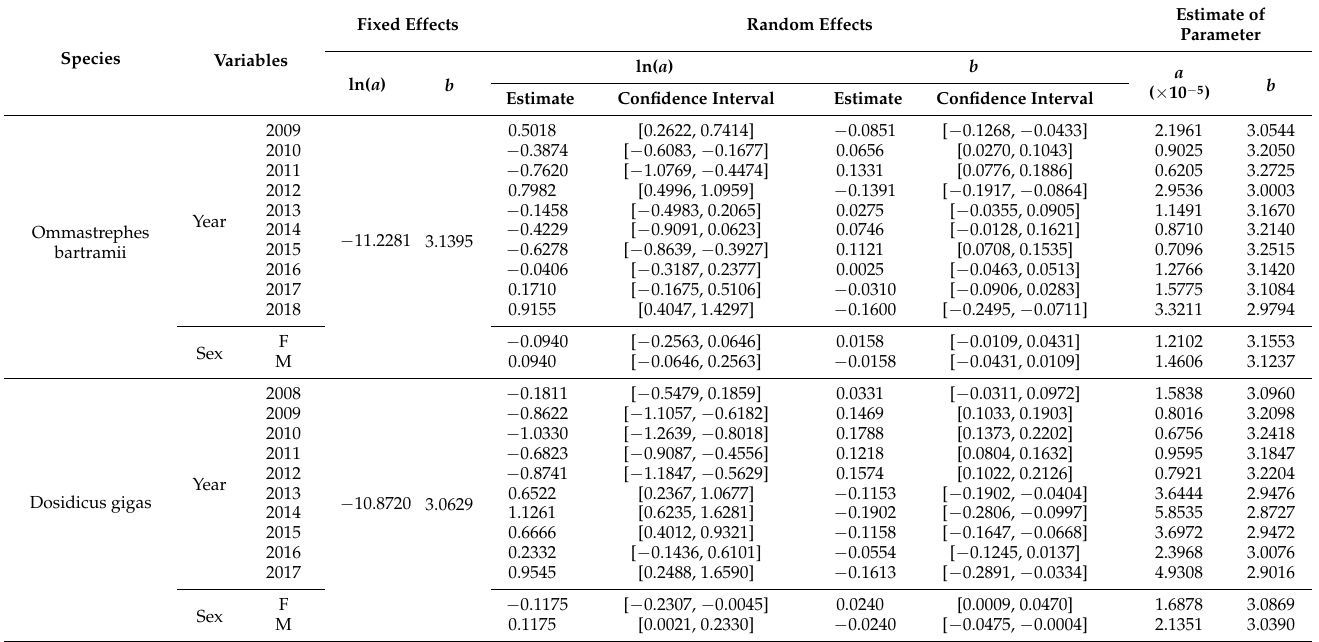
Figure 5. The mantle length–weight relationships of O. bartramii and D. gigas based on the generalized linear model. Table 4. Estimates values for parameters a and b in the LMEM (R and Y.I and